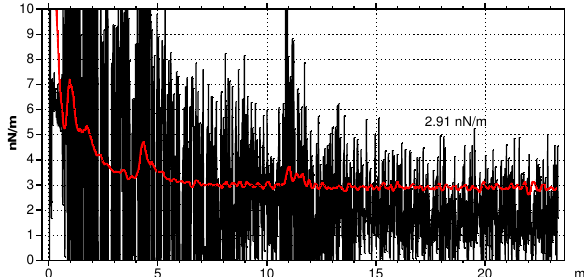
Figure 15. Run V1000BzLong: V w = 756 . 69V, B z = 30 000nT and 23.4ms duration.